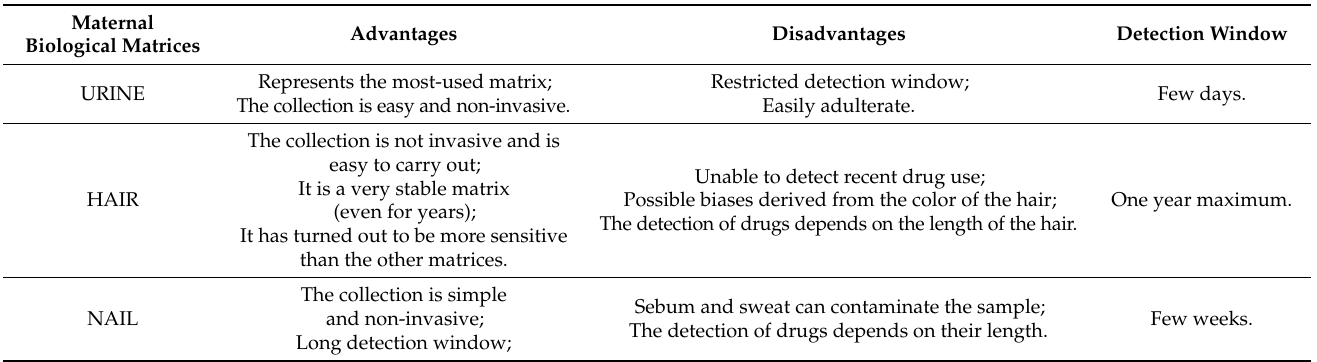
Table 1. The properties of maternal biological matrices